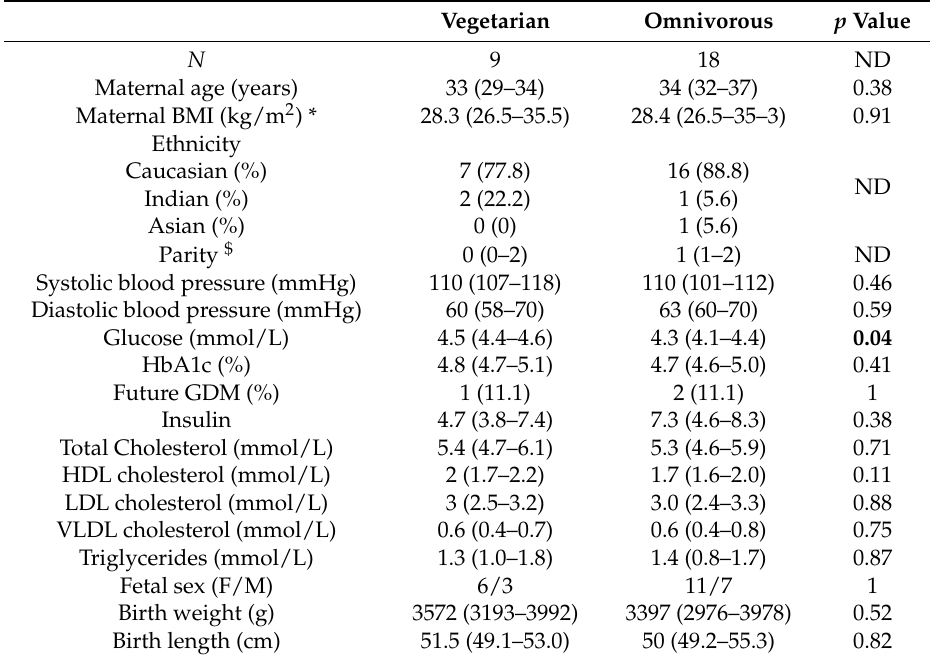
Table 1. Participant characteristics.